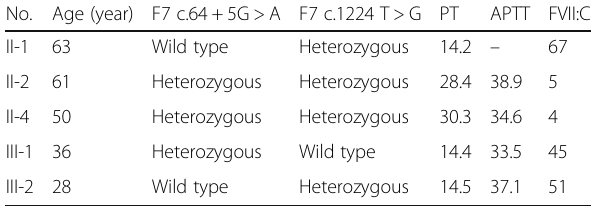
Table 2 Congenital FVII deficiency